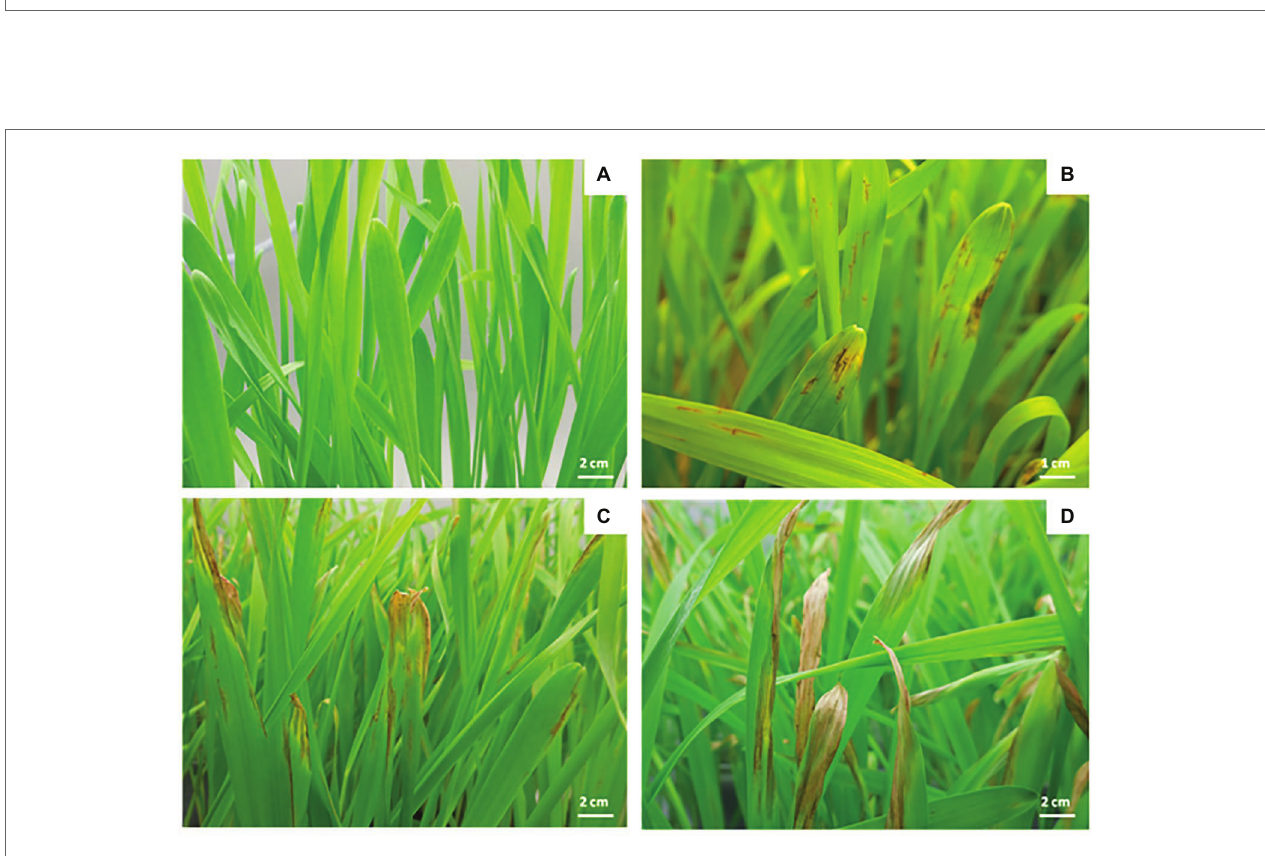
FIGURE 2 | Symptoms caused by P. teres on Siberia barley leaves. Control (A) , 4 days after infection (B) , 7 days after infection (C), and 10 days after infection (D)